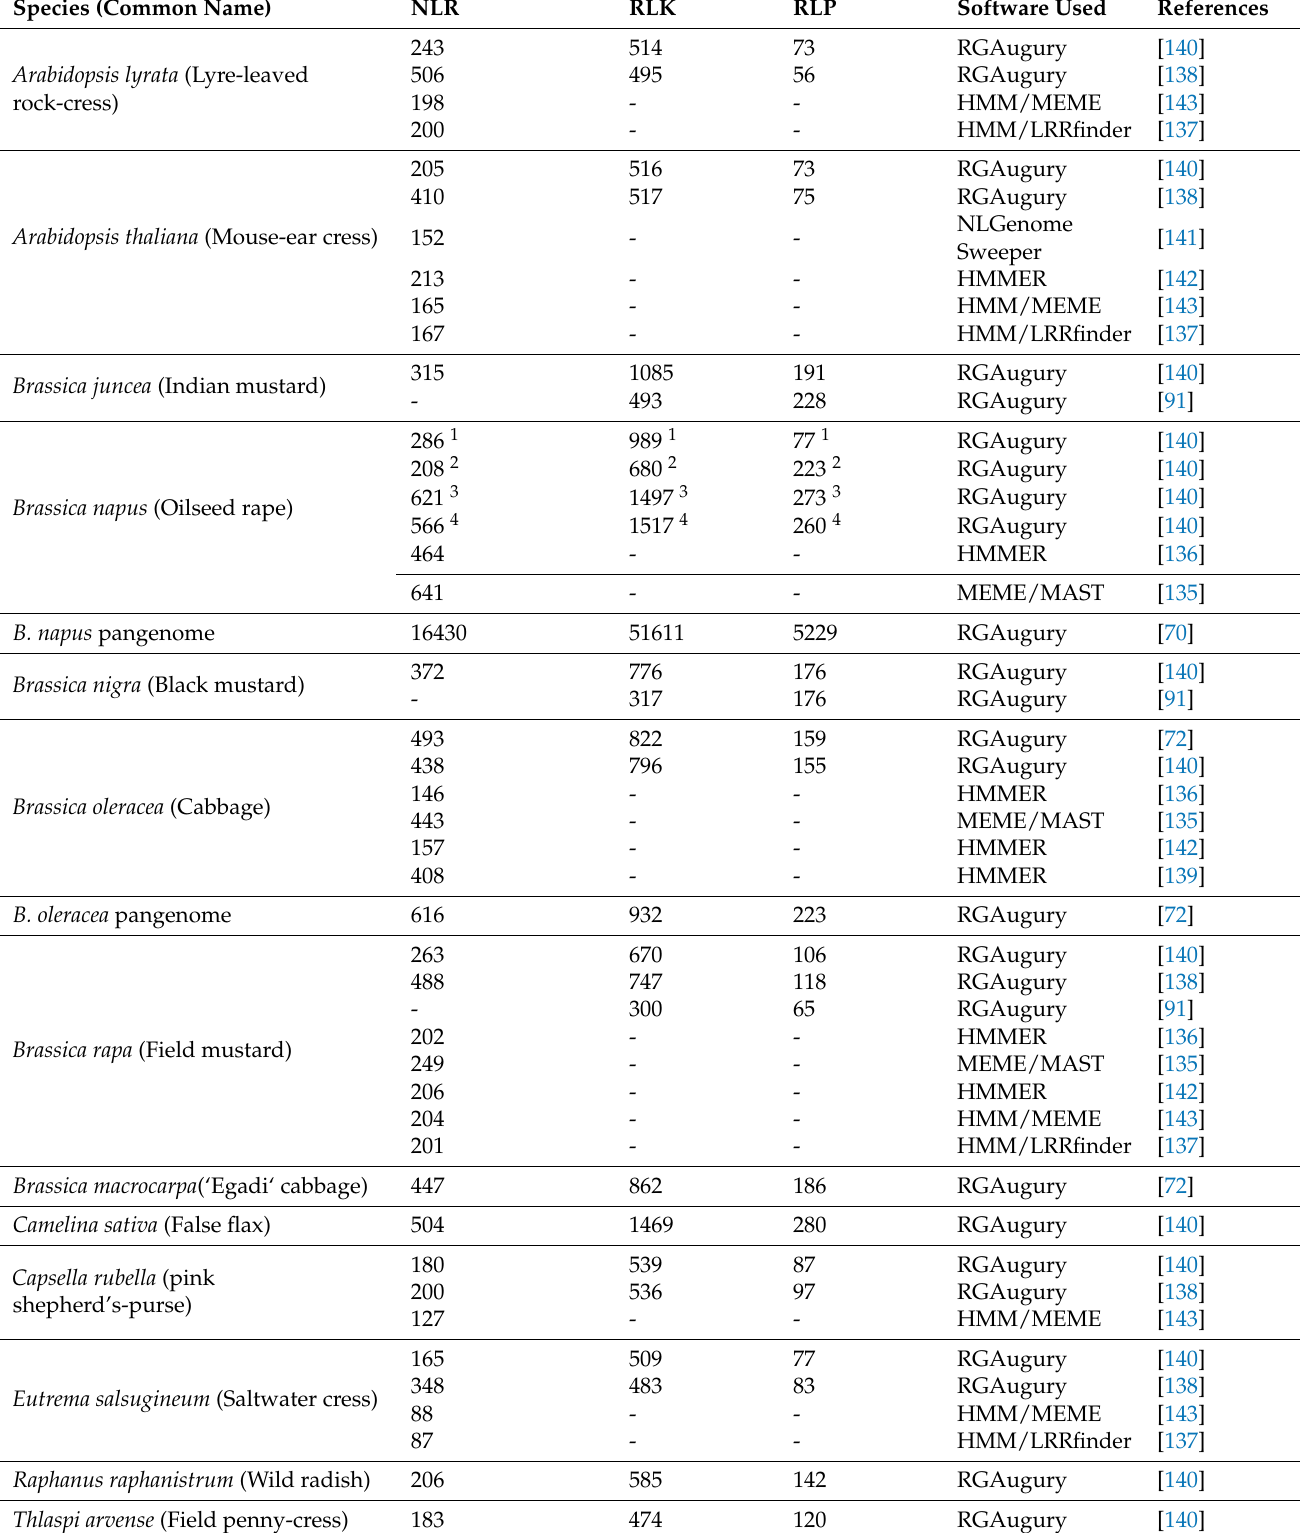
Table 4. List of Brassicaceae species containing resistance gene analogs like nucleotide-binding site leucine-rich repeat (NLR), receptor-like protein kinase (RLK), and receptor-like protein